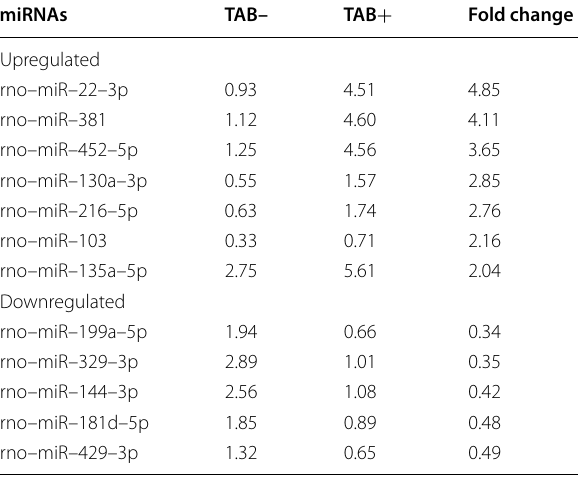
(Fig. 4B, C). In TAB-M and –H groups, the regulatory effects of TAB on miR-329-3p expression were more sig- nificant (all P < 0.001).